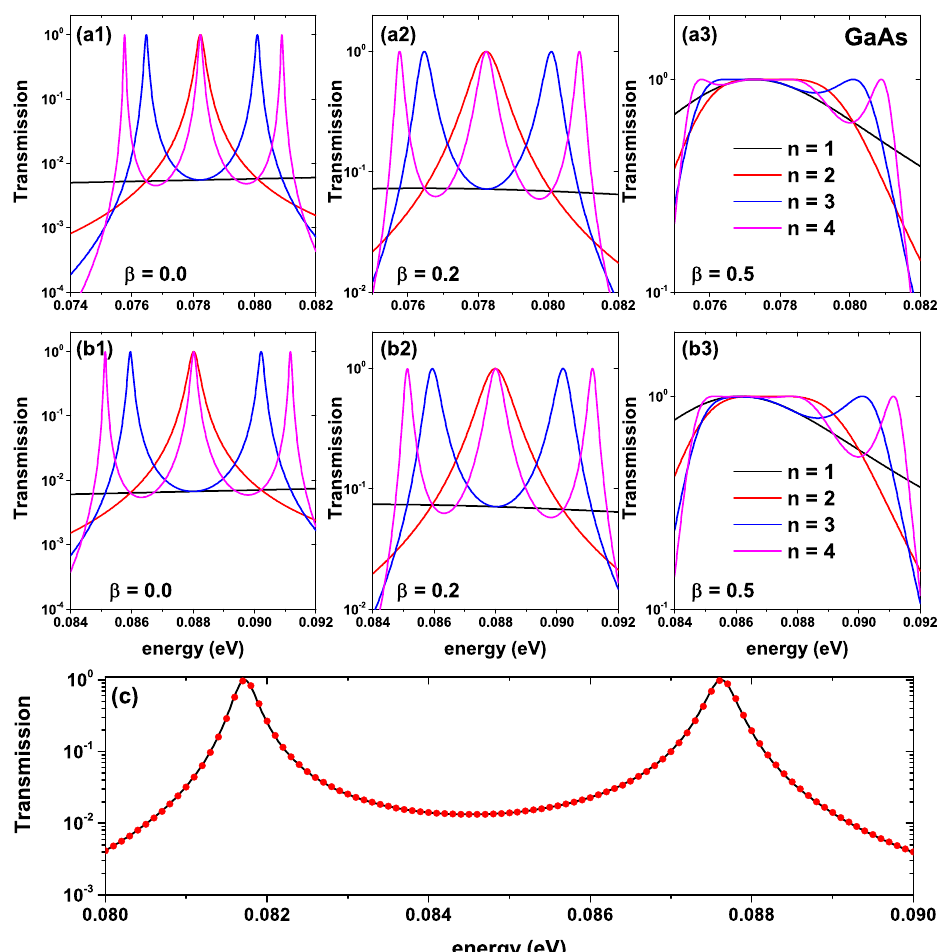
Figure 3. Energy dependence of the electronic transmission probabilities for a GaAs-Al 0.3 Ga 0.7 As finite lattice, according to Figure 2, i.e., varying the n -number of periods and the shape according to the structural β -parameter. Results are without ILF effects (( a ) panels) and with α 0 = 1nm (( b ) panels). In ( a1 ), α 0 = 0nm and β = 0.0. In ( a2 ), α 0 = 0nm and β = 0.2. In ( a3 ), α 0 = 0nm and β = 0.5. In ( b1 ), α 0 = 1nm and β = 0.0. In ( b2 ), α 0 = 1nm and β = 0.2. In ( b3 ), α 0 = 1nm and β = 0.5. ( c ) Comparison between the transfer matrix method and the